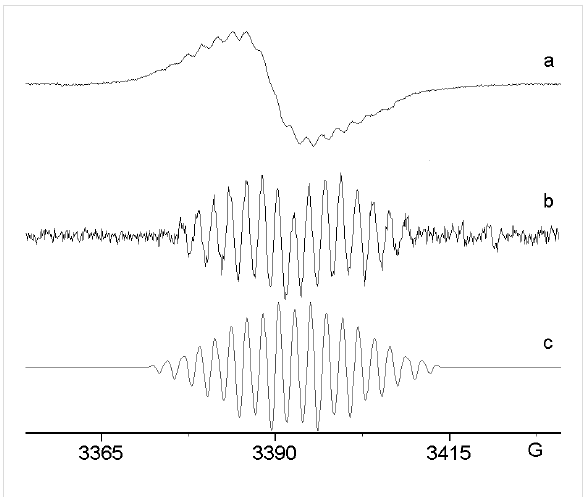
Figure 3: EPR spectra after treatment of azide 1 with AlCl 3 . (a) 1st derivative spectrum in DCM at 280 K. (b) 2nd derivative spectrum after digital removal of residual broad central component. (c) computer